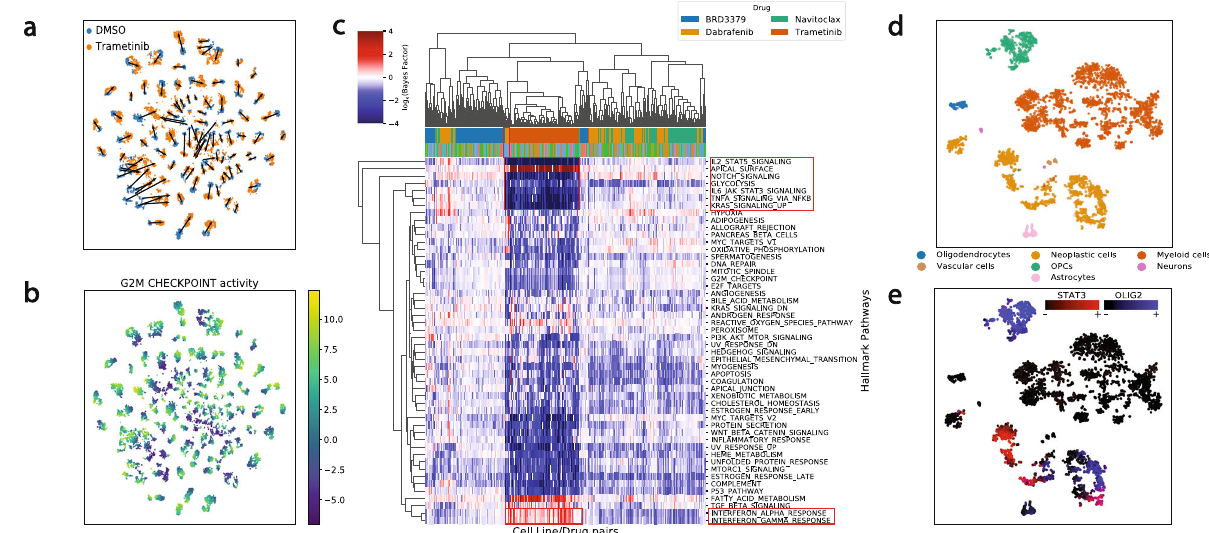
Fig. 2 The fl exibility in the latent space speci fi cation sheds light on the activity of core cellular processes and transcription factors. a tSNE embedding of the latent space of VEGA for the MIX-Seq data 21 . The color indicates the treatment condition, and the arrow indicates the median shift in coordinates of each cell line between the two conditions. b Inferred G2M checkpoint activity of each cells, showing a decreased activity in the treated condition, as expected from the MoA of Trametinib. c Heatmap with hierarchical clustering showing the average log e (Bayes Factor) of each pathway for each cell line/ drug treatment pair (test between DMSO and treatment condition). Each row corresponds to a hallmark gene set and each column to a different cell line/ drug pair. The fi rst row of color indicates the drug, and the second row of color indicates the tissue identity (Tissue legend available in SFig. 2). Highlighted cell lines correspond to BRAF-mutant melanoma. Highlighted activities correspond to Trametinib-speci fi c responses. d tSNE embedding of the latent space of the model for the glioblastoma dataset 29 , colored by cell type or e Inferred activity of the master regulators STAT3 and